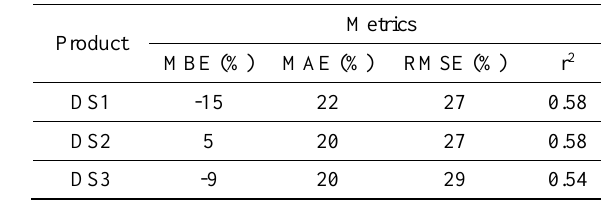
Table 1. Error metrics of the three Landsat-based tree cover datasets. The units of MBE, MAE and RMSE are all percent tree canopy cover.